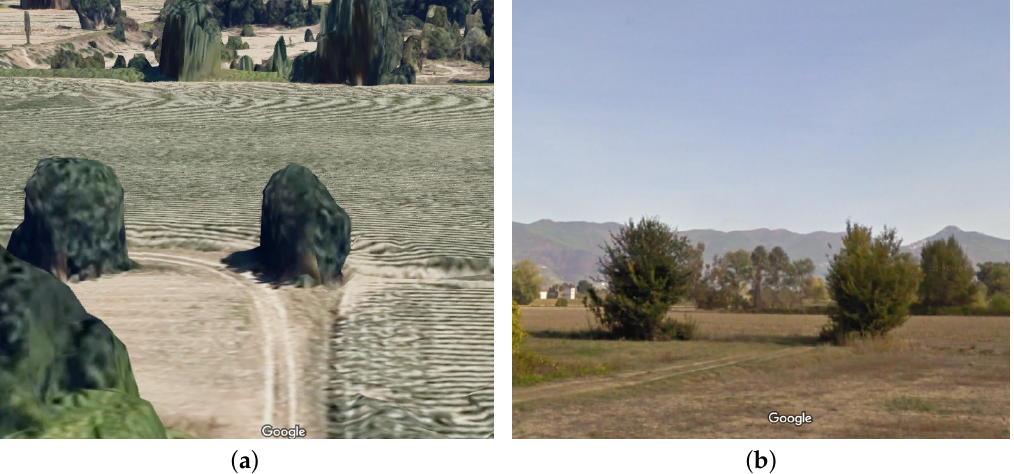
Figure 21. The Facing area in cell (4,4). ( a ) Google Maps 3D image for the cell containing obstacle; ( b ) Google Maps street view image for the facing